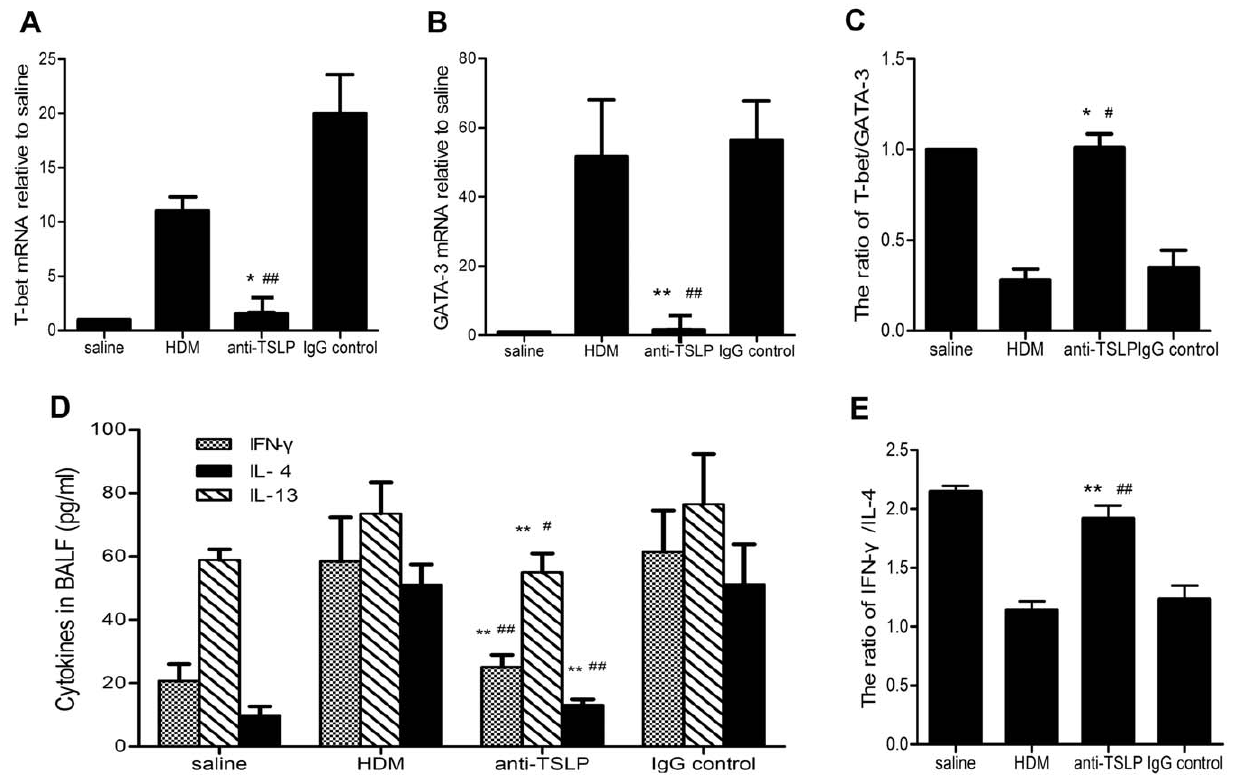
Figure 5. TSLP neutralization in the lung alters Th2-typed responses. The expression levels of T-bet mRNA (A) were elevated in all of the treatment groups following prolonged exposure to HDM for 5 weeks, whereas the expression levels of GATA-3 mRNA (B) were increased in the repeated HDM exposure group and the IgG-treated control mice. However, the T-bet/GATA-3 ratio (C) was lower in both the prolonged HDM exposure group and in the IgG-treated control mice, compared with both the anti-TSLP treatment group and the saline-treated control mice. The relative quantitative mRNA levels in the lung homogenate were detected using RT-PCR (D). The levels of the Th1-associated cytokine IFN- c in the BALF were elevated in all of the subphenotype groups following exposure to HDM for 5 weeks. The levels of the Th2-associated cytokines IL-4 and IL- 13 in the BALF were higher in the prolonged HDM-exposed group and in the IgG-treated control mice than in both the anti-TSLP mAb- and saline- treated control mice. However, IFN- c /IL-4 ratio (E) was lower in both the prolonged HDM exposure group and the IgG-treated control mice than the ratio that was observed in the anti-TSLP mAb- and saline-treated control mice. The cytokines were elevated based on ELISAs. The data shown represent the means 6 SEM (n=5), mRNA value=2 2 DD Ct , DD Ct= (Ct Target -Ct Actin ) of the treated mice–(Ct Target -Ct Actin ) of the saline control mice. * p , 0.05 or ** p , 0.01 compared with the HDM group. # p , 0.05 or ## p , 0.01 compared with the IgG-treated controls. The results are derived from 4 experimental groups (5 mice/per group), and both protein and mRNA levels were determined in